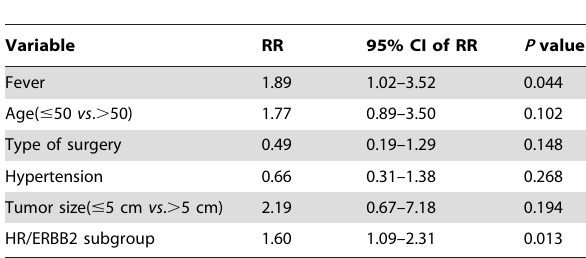
Table 2. Multivariate Cox proportional hazards regression analysis for RFS in 883 ALN negative breast cancer